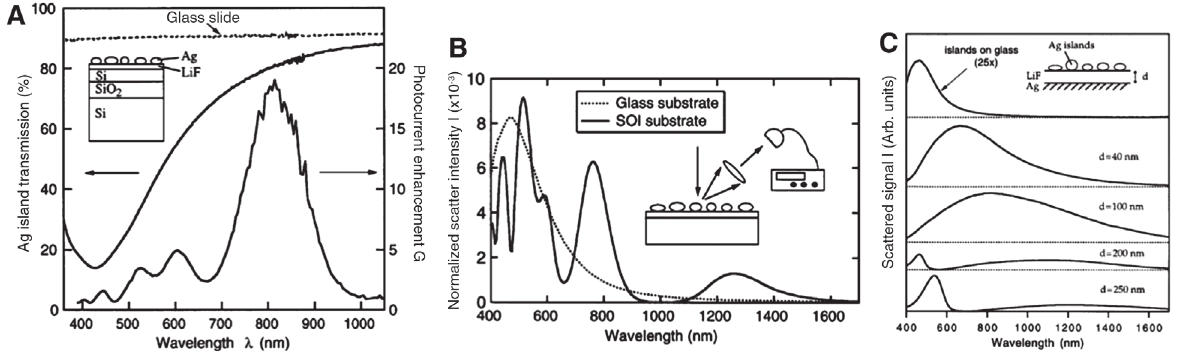
Figure 8: (A) Experiment of Stuart and Hall [29]. Transmission spectrum of a Ag-island film on a LiF-coated glass substrate, along with the measured photocurrent enhancement G produced by an identical Ag-island film formed on an SOI photodetector. The island-SOI structure is shown in the inset; the Si and SiO2 layer thicknesses are 160 and 200 nm, respectively. (B) Measured intensity of scattered light (normal- ized to the incident intensity) for a Ag-island film formed on LiF- coated glass (dotted line) and SOI (solid line). LiF thickness is 30 nm.